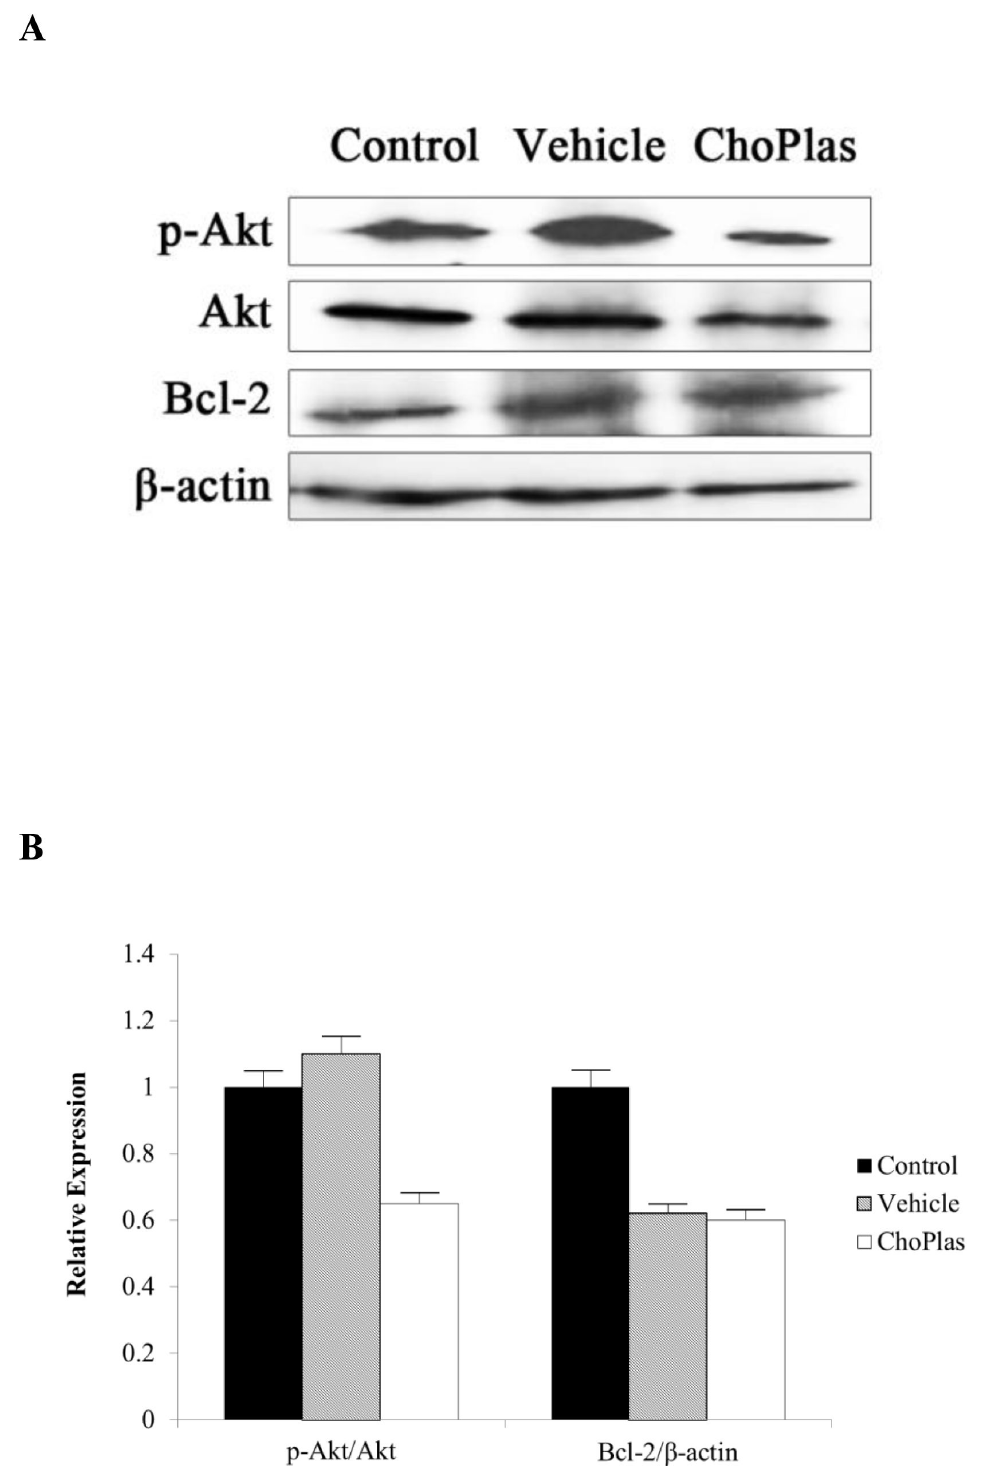
Figure 5. Effect of ChoPlas on Akt/PI3K pathway proteins. CBRH7919 cells were treated with 25 μmol/L of ChoPlas for 24 h and then harvested. (A)Total protein was extracted and then blotted with phosphor-Akt(Thr 308 ), total Akt and Bcl-2 antibodies; (B) Graph depicting the semi-quantization of phosphor-Akt(Thr 308 ), total Akt and Bcl-2 expression computed using Image J software. Data are presented as the mean±S.D (n=3). doi: 10.1371/journal.pone.0077387.g005 PLOS ONE |